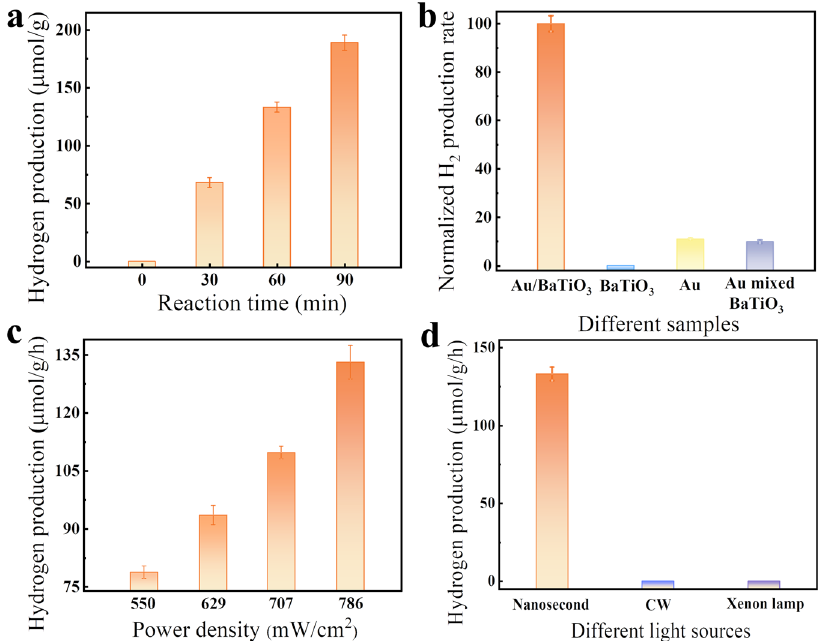
Fig. 3 | H 2 generation from water splitting by Au/BaTiO 3 NPs. a Hydrogen gen- eration under different reaction time. b Normalized H 2 production rate (normal- ized to the production rate of Au/BaTiO 3 NPs) of different samples under the irradiation by a 532nm nanosecond laser. c Hydrogen generation under the